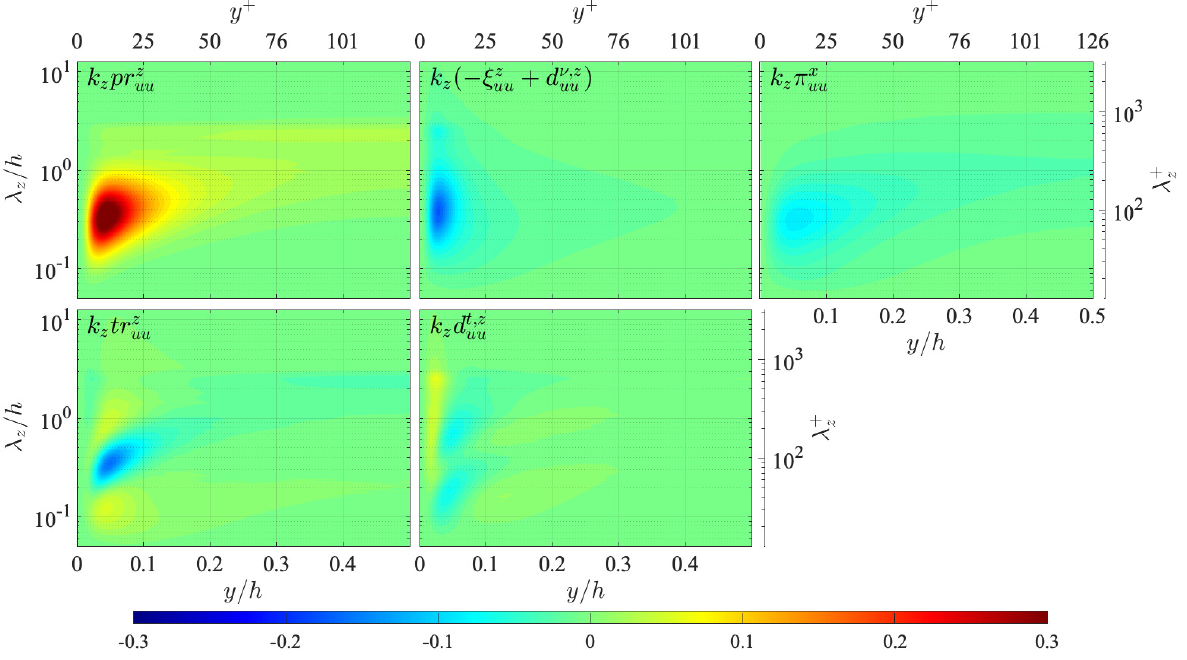
Figure A1. Distribution of terms in the transport equation of the streamwise turbulent energy spec- trum E z uu , presented in the same manner as in Figure 12: ( top left ) production pr z uu ; ( top centre ) vis- cous terms ξ z uu + d ν , z uu ; ( top right ) pressure-strain energy redistribution π z uu ; ( bottom left ) interscale transport tr z uu ; ( bottom centre ) turbulent diffusion d t , z uu . The terms are presented in the premultiplied form, and the values are scaled by u 4 τ / ν